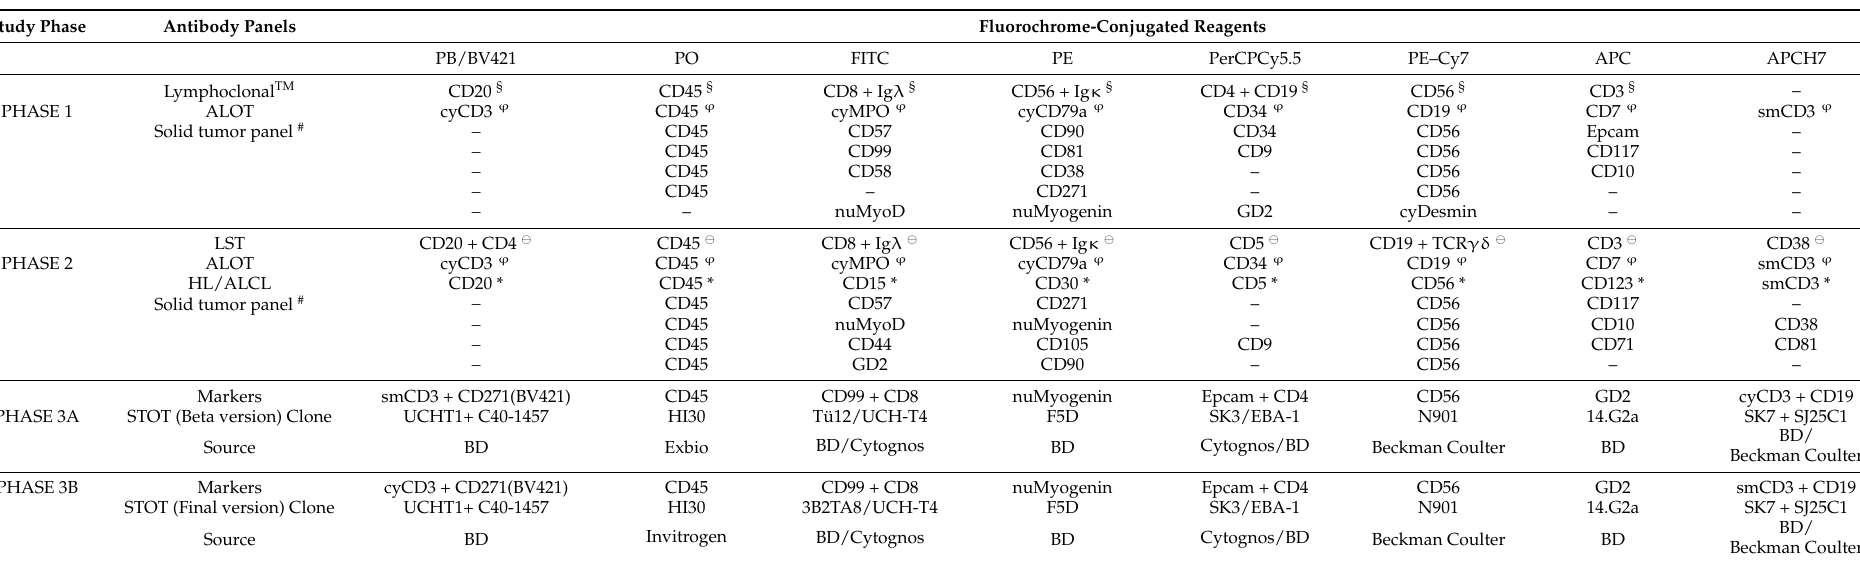
Table 2. Antibody combinations evaluated along the different cycles of ‘design–test–redesign’ until the final version of solid tumor orientation tube (STOT) was built for the diagnostic screening and classification of pediatric non-hematopoietic